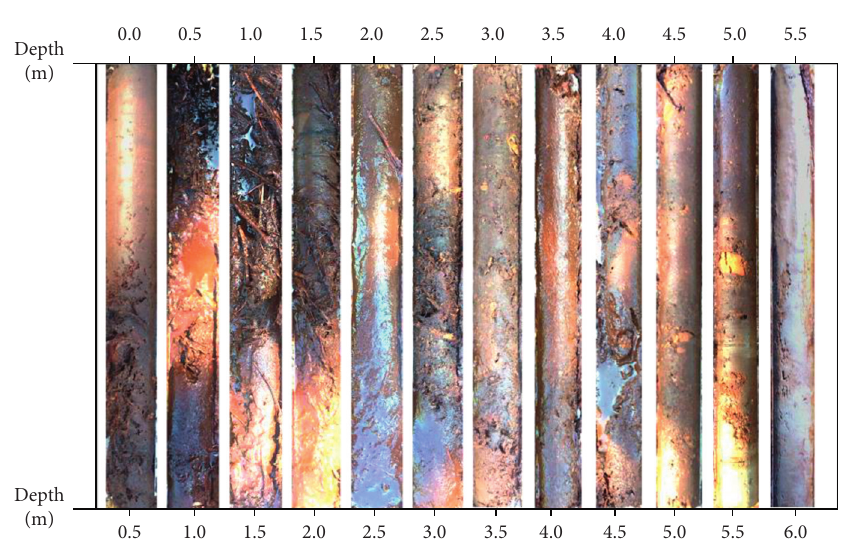
Figure 3: Soil profile for S2.